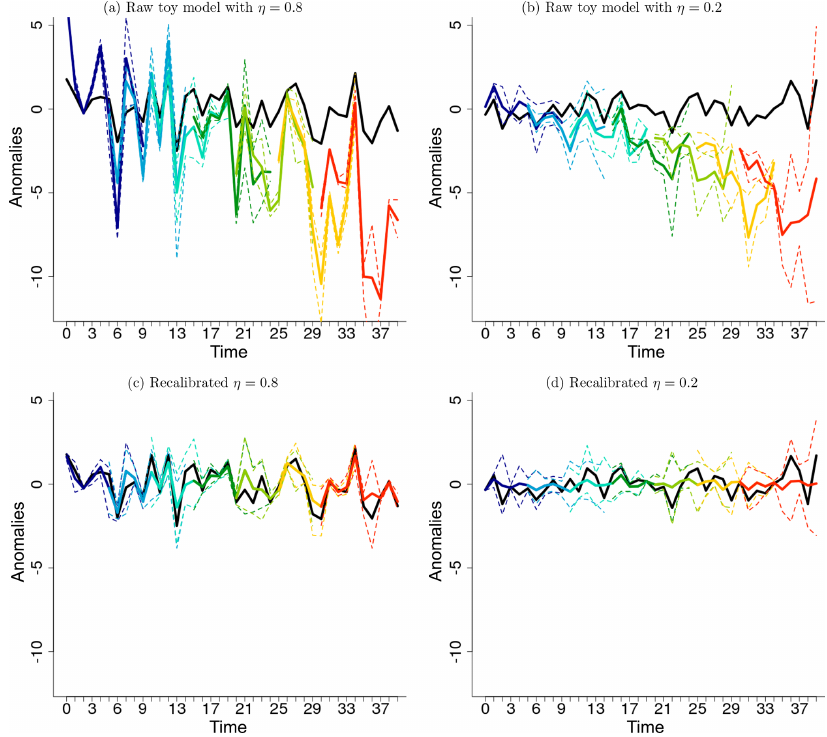
Figure 2. Temporal evolution of the raw (a, b) and DeFoReSt recalibrated (c, d) pseudo-forecasts for different start years (colored lines) with potential predictability η = 0 . 8 (a, c) and η = 0 . 2 (b, d) . Each pseudo-forecast runs over 10 lead years. The black line represents the associated